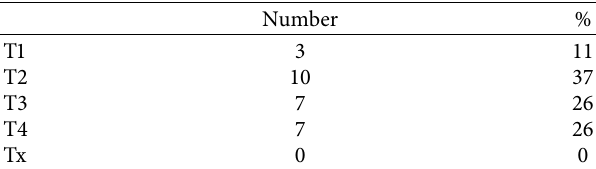
Figure 5: Abdominal CT showing diffuse secondary hepatic locations. Table 4: Tumor’s grading at the